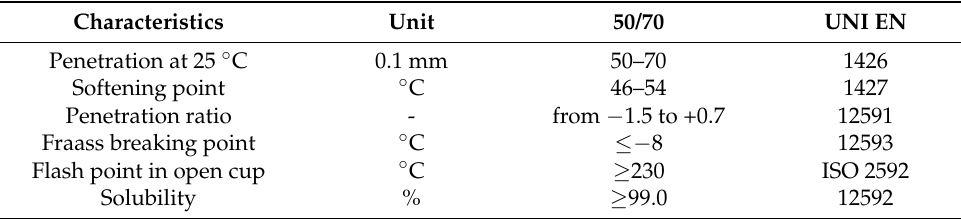
Table 1. Some of the physical properties of the bitumen used. Characteristics Unit